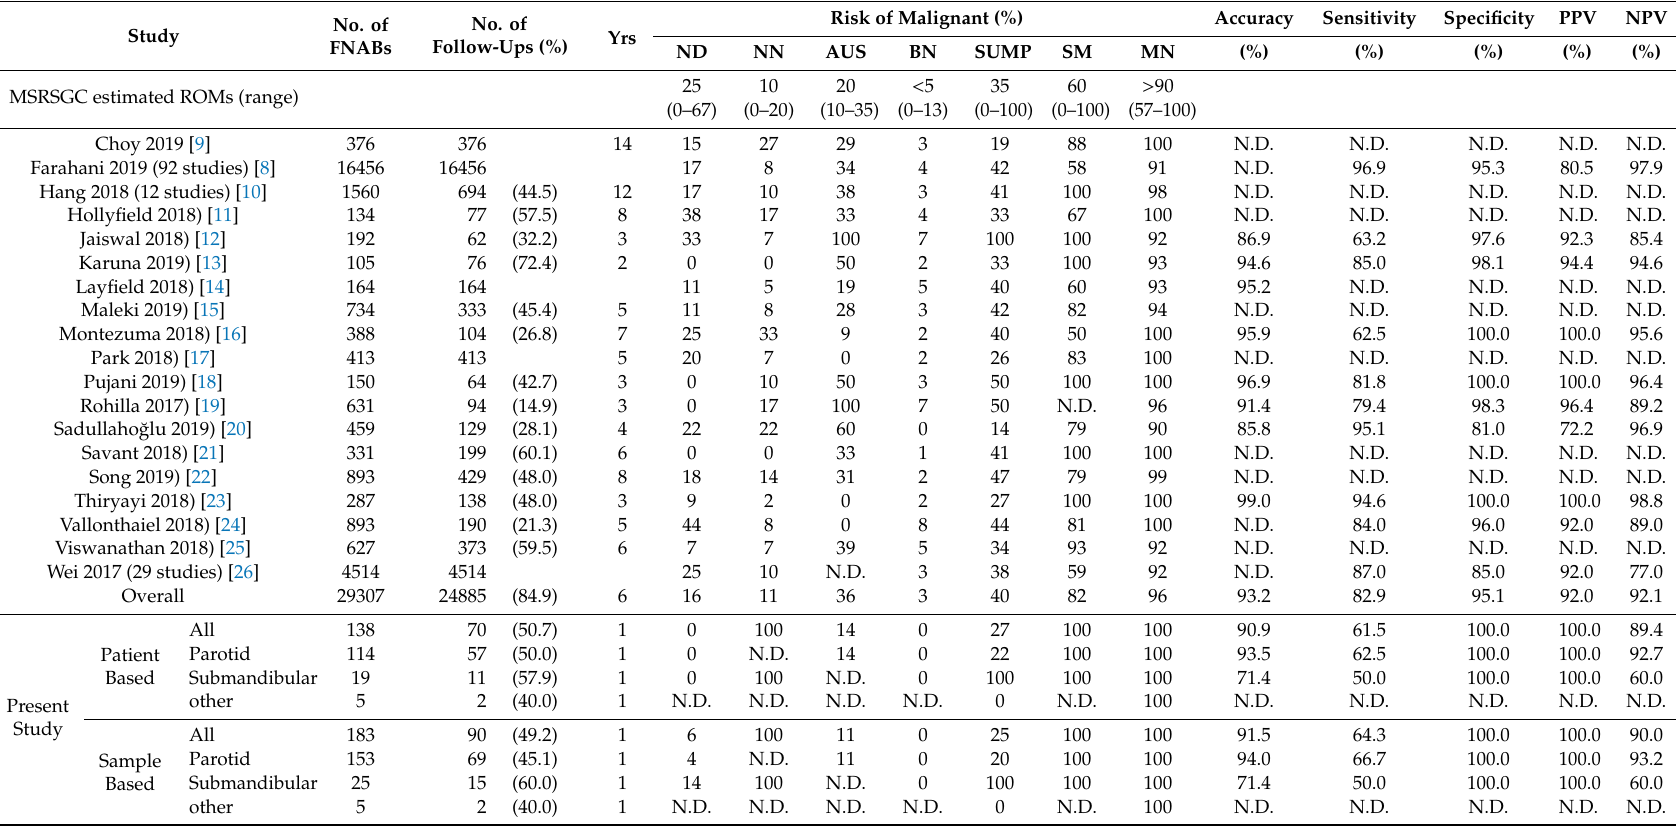
Table 4. Comparison with Other Studies and MSRSGC